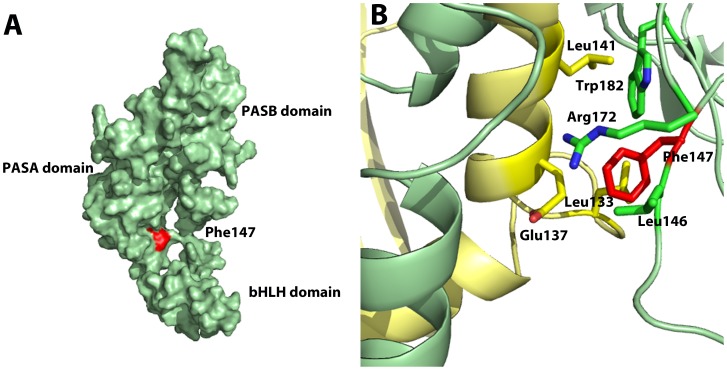
Homology model highlighting residue Phe147 of NPAS4. NPAS4 is colored green and ARNT2 is colored yellow.A) The NPAS4 subunit is depicted as a surface representation. The location of Phe147 is shown by red color. B) The NPAS4-ARNT2 heterodimer is depicted as a ribbons diagram. Phe147 is shown at the interface with side chain shown as sticks colored red, together with amino acids within 3.5 angstroms. Phe 147 is part of a hydrophobic pocket formed with ARNT2 residues (Leu 133, Leu 141) and NPAS4 residues (Leu 146, Trp 182).